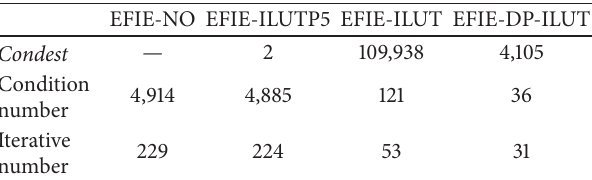
Table 1: Condest , condition number, and iteration number of different preconditioned linear systems equation